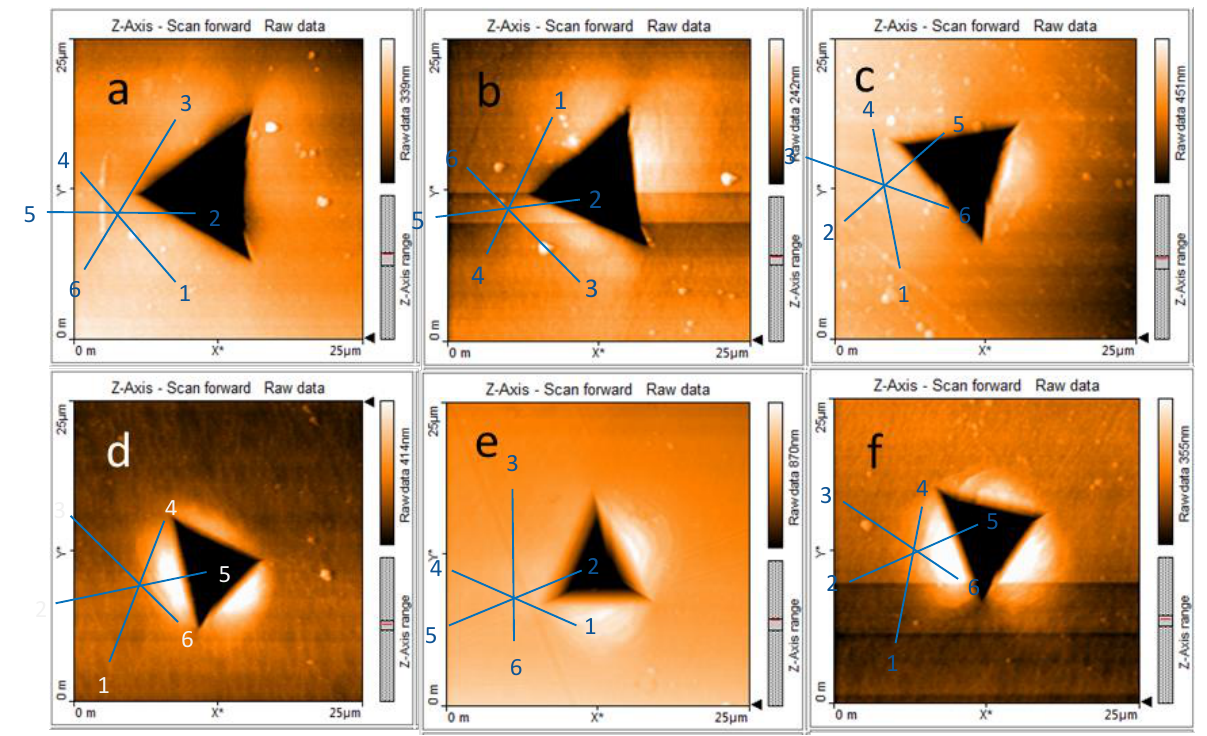
Figure 5. AFM images of Fe after nanoindentation: ( a ) Fe-AR-RT, ( b ) Fe-AR-125 °C, ( c ) Fe-AR-300 °C, ( d ) Fe-15%-RT, ( e ) Fe-15%-125 °C, ( f ) Fe-15%-300 °C, with the directions numbered as shown for the depth profiles of Figure 6.